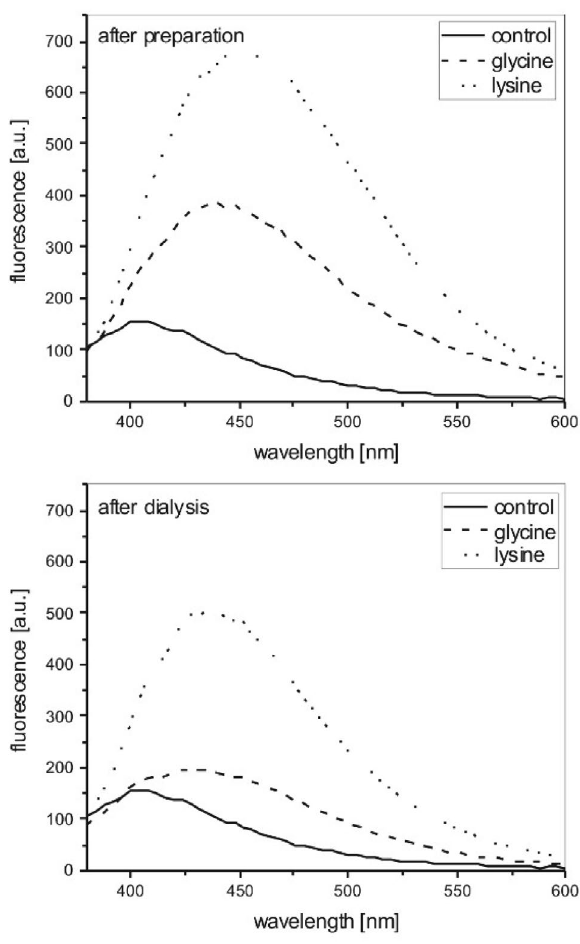
Figure 14. Fluorescence emission spectra of solutions prepared with the amino acids glycine or lysine. For activation, light with 360 nm is used. Presented are spectra from solutions prepared with a process temperature of 140 °C and a process duration of 15 minutes.